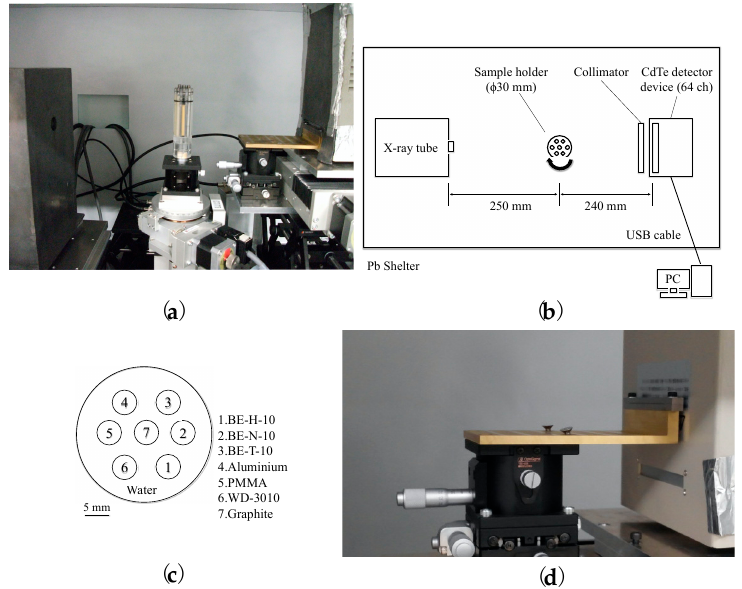
Figure 5. ( a ) picture of the photon-counting computer tomography (CT) system ( b ) schematic view of the photon-counting CT system, ( c ) position of each sample in the sample holder, ( d ) picture of the collimator installed in front of the cadmium telluride (CdTe) detector device.